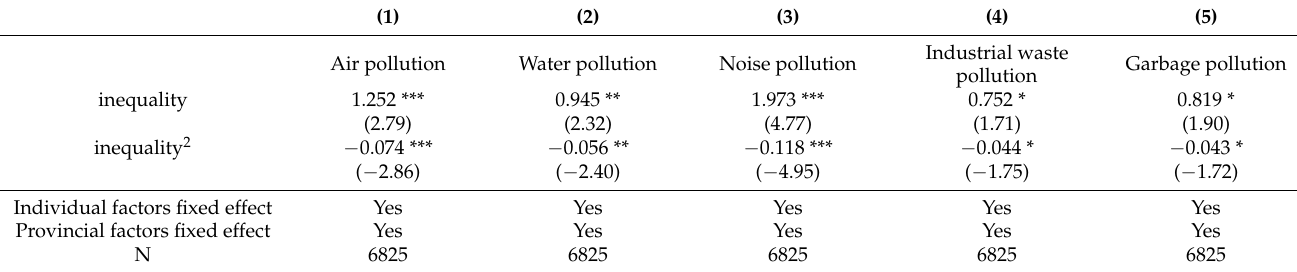
Table 3. The effect of individual-level income inequality on different subjective environmental